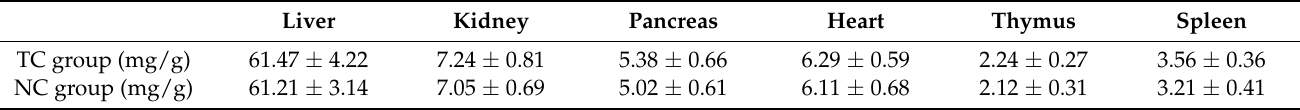
Figure 17. Effects of [CrBCA 3 ] on some microanatomical features of the rats in sub-acute toxicity studies. Table 7. Organ indices of mice in each group (means ± SD, n =